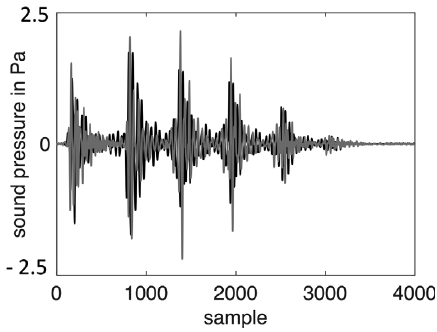
Figure 8. Time signal of the pressure signal at the listener position for the fi rst fi ve steps for the simulation (black line) and the recording (gray laine) on fl oor M10.